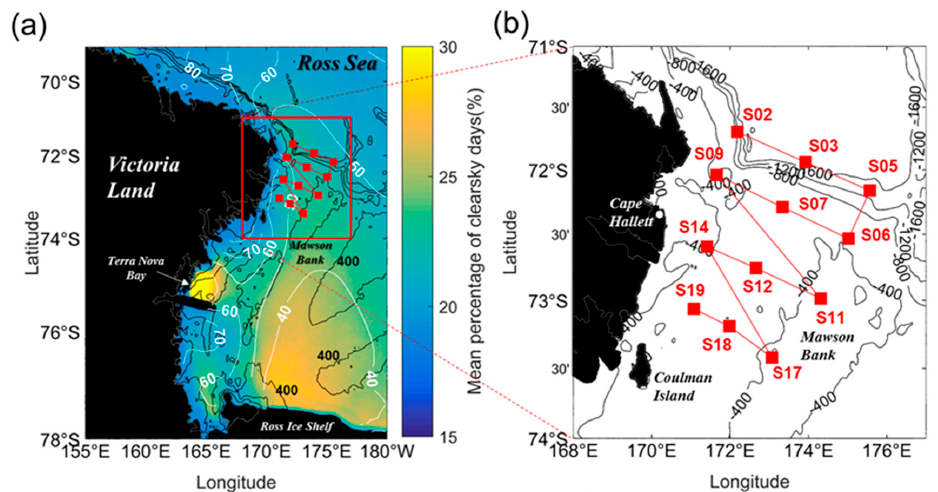
Figure 1. ( a ) Map of the western Ross Sea. The background color indicates the mean percentage of clear-sky days during the study period (1998 / 1999–2017 / 2018). The black and white contours represent the bathymetry ranging from 1600 to 400 m depth and the mean sea ice concentration, respectively. ( b ) The study area o ff Cape Hallett. The red squares represent the sampling stations, and the red lines indicate the path of the ANA08C